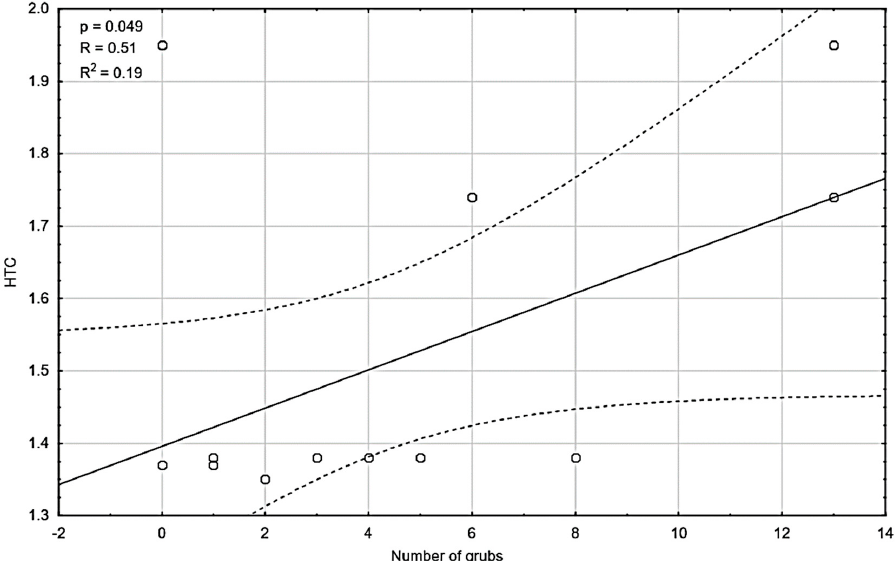
Figure 5. Relationship between the hydrothermal coefficient (HTC) and the total number of grubs in